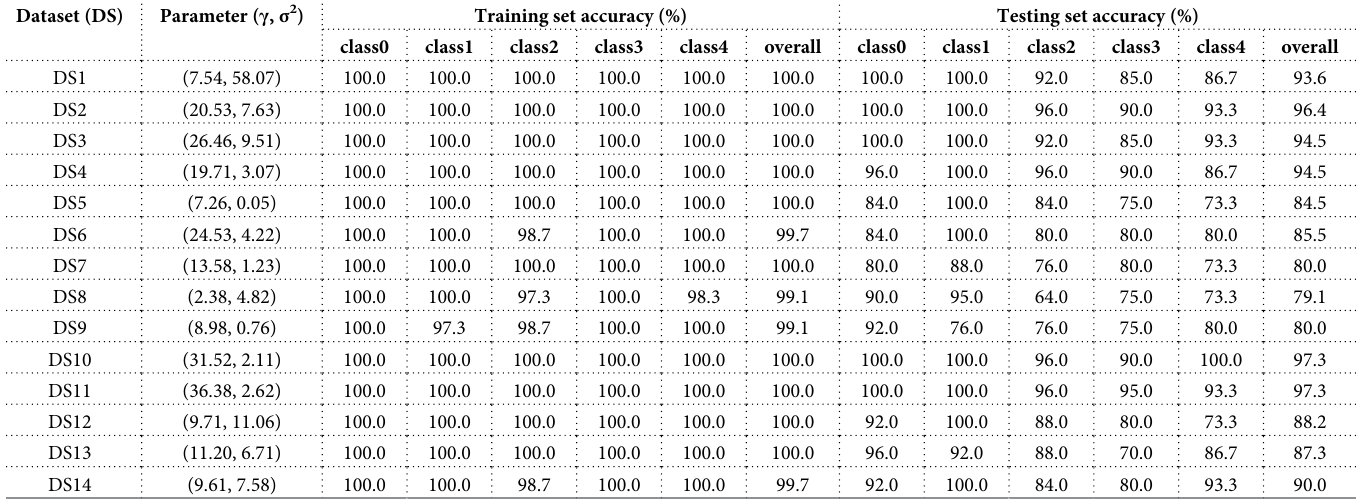
Table 7. Overall and individual class classification accuracies of LS-SVM models with different datasets. Dataset (DS)